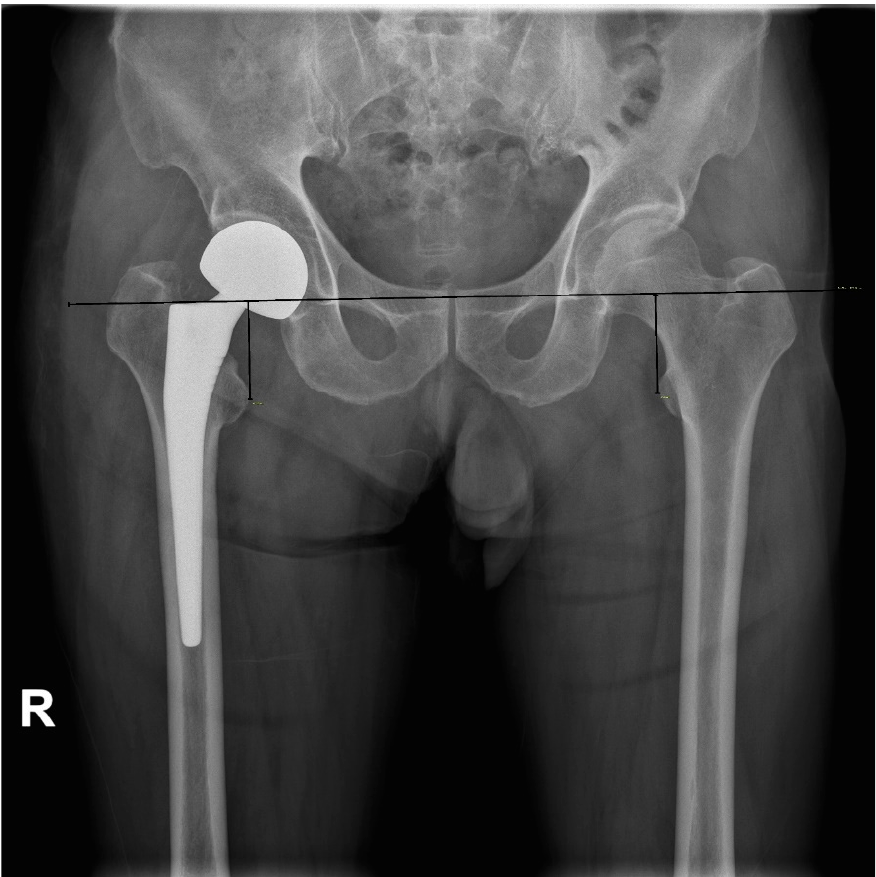
Figure 6. Leg length discrepancy measurement postoperatively, described by Ranawat et al. [23]